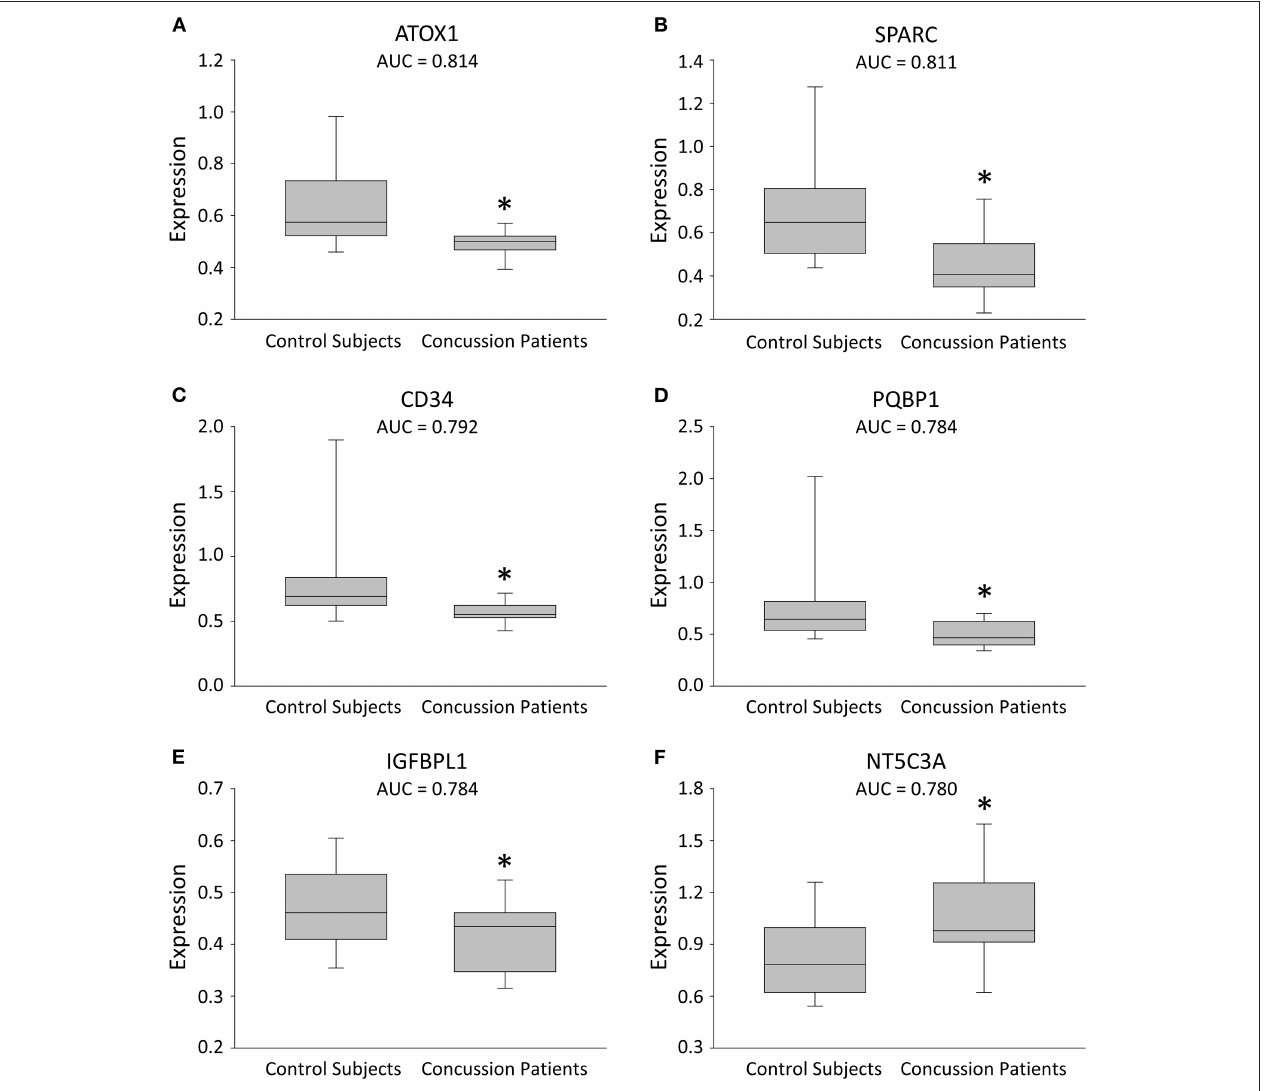
FIGURE 1 | Box plots illustrating expression changes in the leading 6 proteins for concussion diagnosis. (A–F) Box plots comparing plasma expression in concussion patients and their matched healthy control subjects. The line within the box marks the median, the boundaries of the box indicate the 25th and 75th percentile, and the error bars indicate the 90th and 10th percentiles. All six proteins were selected based on a cut-off (AUC ≥ 0.78), with a more conservative P value (* P <